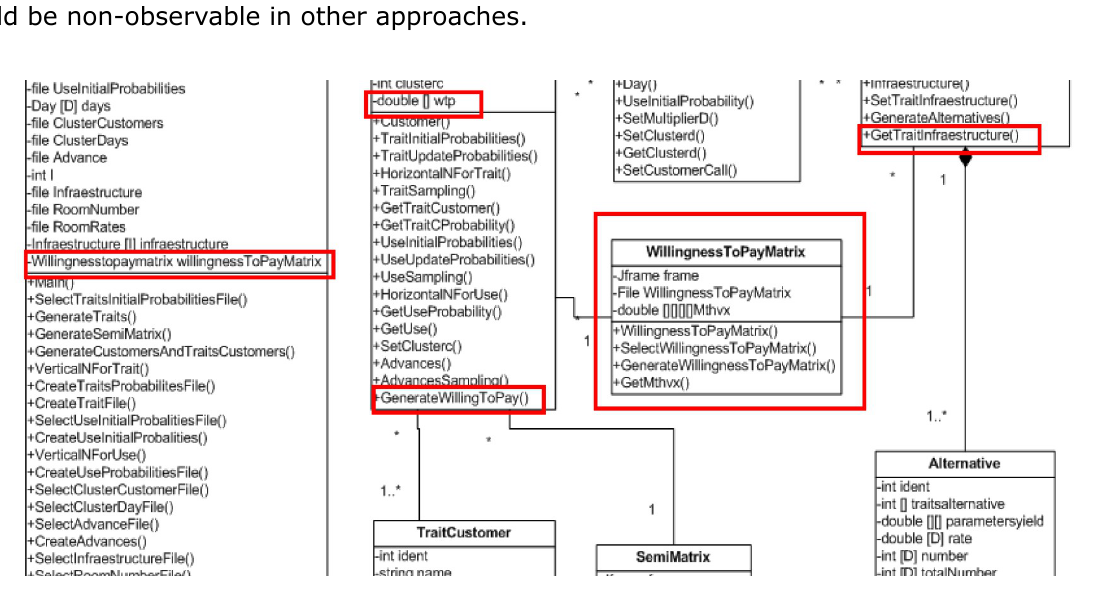
Figure 3. Subset of UML class diagram highlighting the generation of the “Willingness to